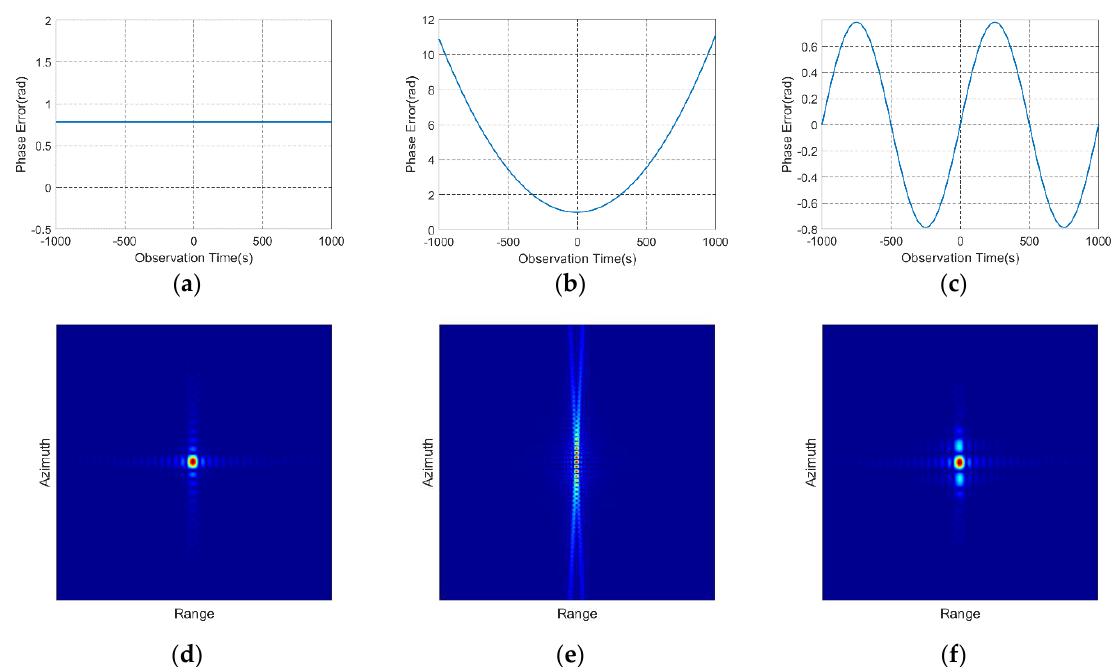
Figure 24. The simulation results of phase distortion. ( a ) The constant phase error. ( b ) The quadratic polynomial phase error. ( c ) The sinusoidal phase error. ( d ) The imaging result of constant phase error. ( e ) The imaging result of quadratic polynomial phase error. ( f ) The imaging result of sinusoidal phase error.